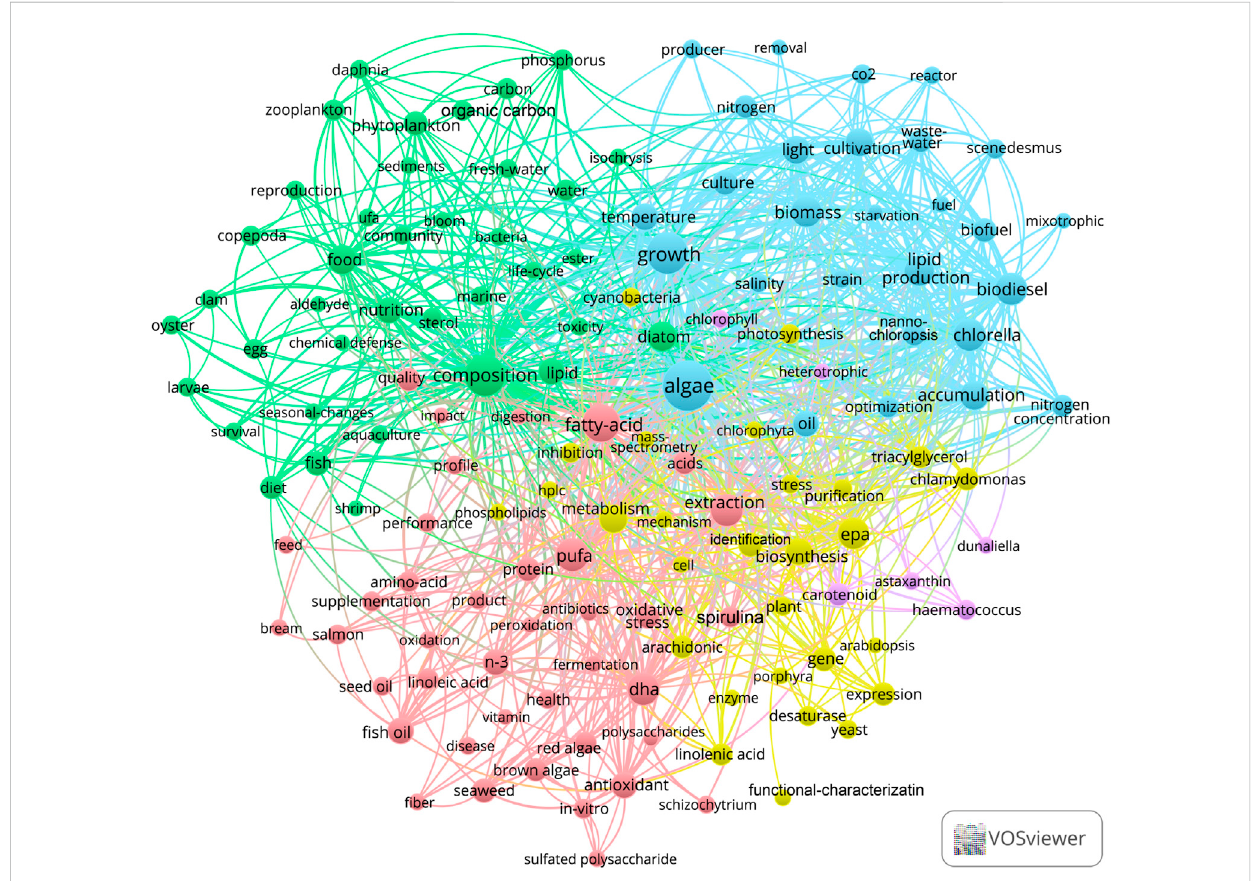
FIGURE 2 The most popular keywords in the articles of algae-PUFA in the Web of Science Core Collection.